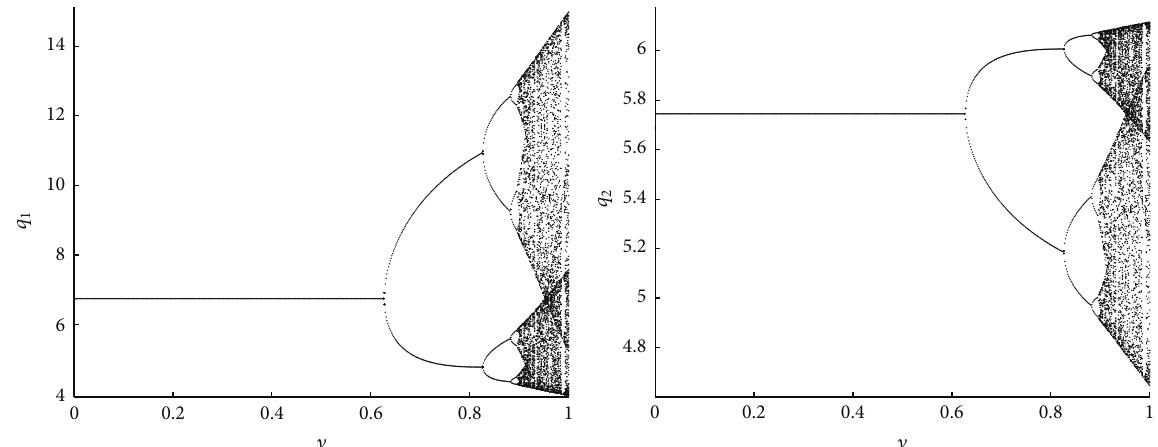
Figure 1: Bifurcation diagrams of quantities 𝑞 1 and 𝑞 2 with respect to the speed of reaction 𝛾 , which always has a destabilizing role.